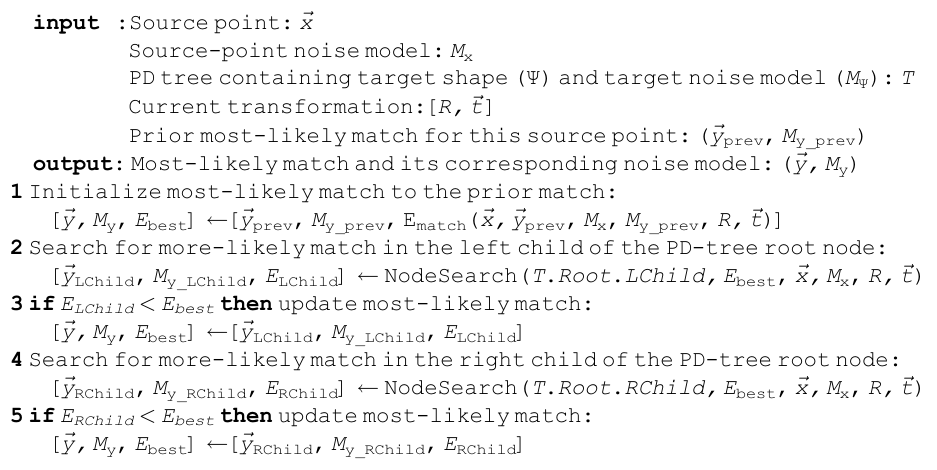
Algorithm 3. PD-Tree Search for Most-Likely Correspondence